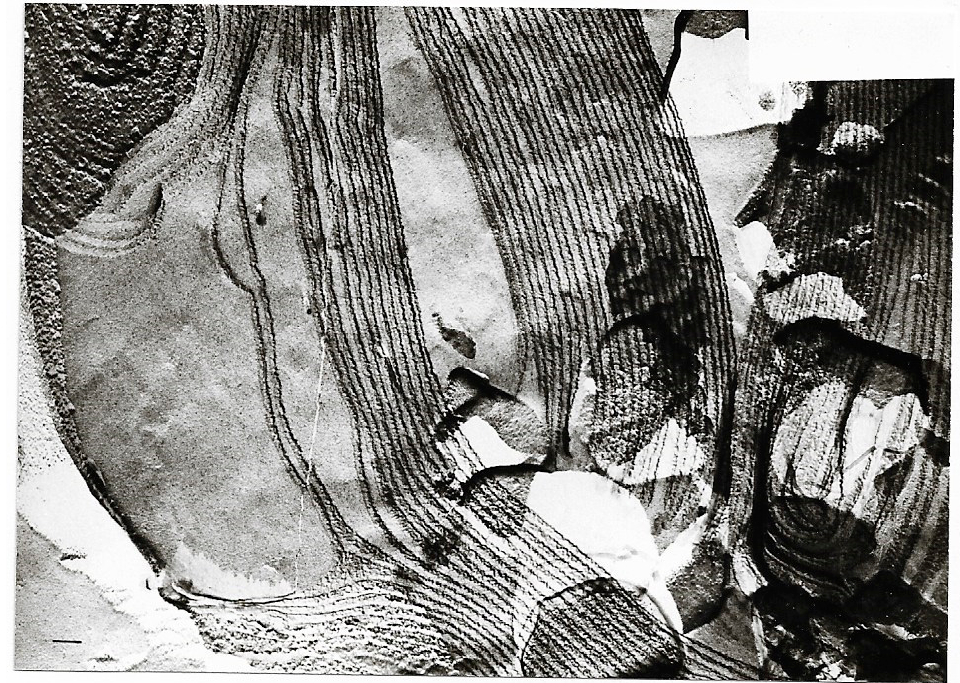
Figure 9. Freeze-fracture electron microscopy of mixed liposomes consisting of 50% MPL and 50% egg lecithin; MPL domains can be seen in the egg lecithin liposomes; magnification ×67,500; bar = 100 nm.